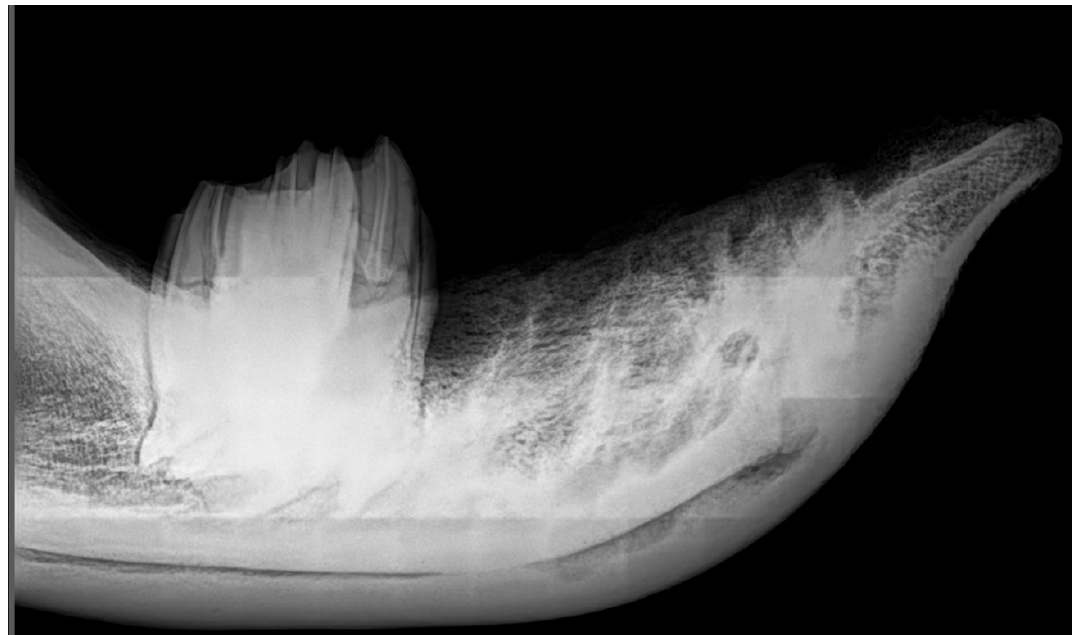
Figure 3. Lateral view X-ray of the mandible of the white rhinoceros female (only M 3 teeth firmly fixed in alveoli left for imaging).